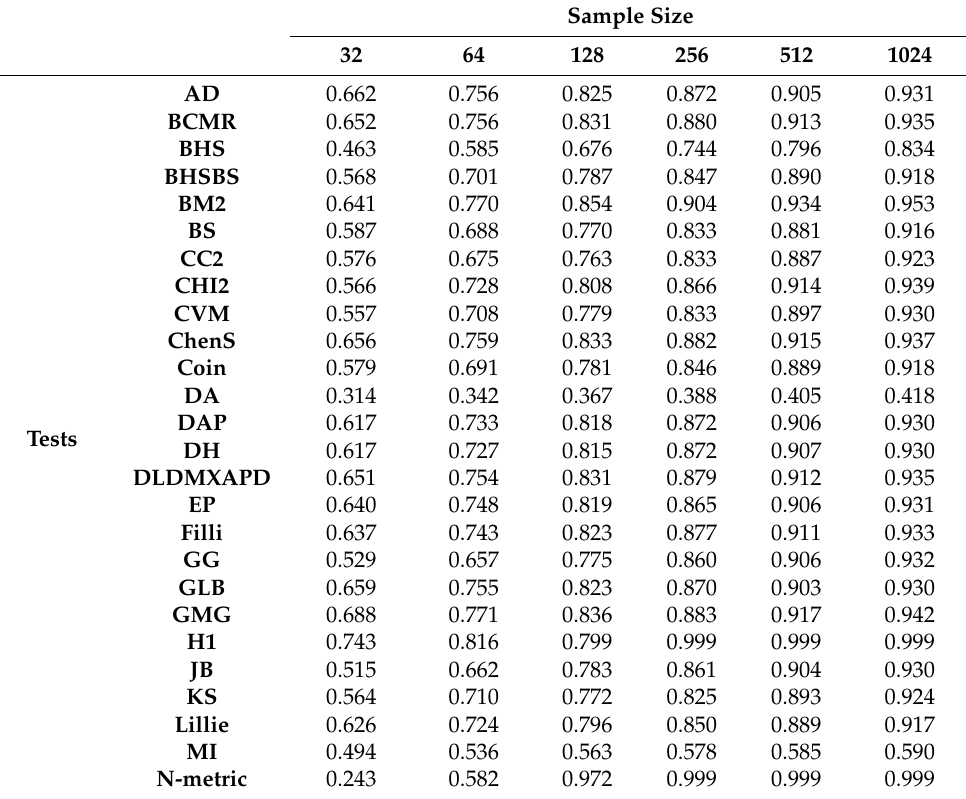
Table 3. Average empirical power obtained for a group of modified normal